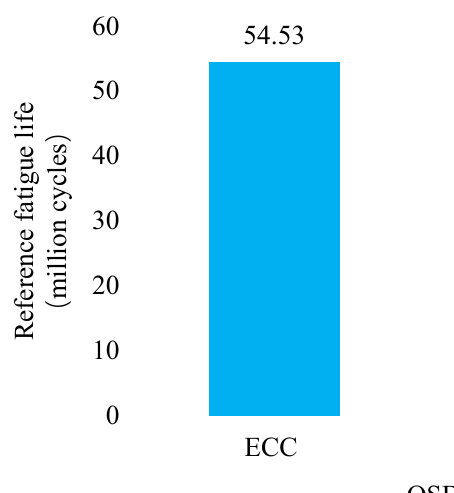
( b ) Binary image of cracks Figure 16. Crack recognition by processing computed tomography (CT) image slices. 4.3.3. Analysis of the Cracking Distribution in Depth Direction In order to study the cracking distribution along depth direction, binary images were processed by a user-defined code [26]. As for the logic of the code, white pixels which represents crack regions were all numbered with value “1”, other regions were marked with value “0”. Therefore, by calculating the summation of each image slice matrix, the size of the crack region in each depth section can be determined. The results are shown in Figure 17.